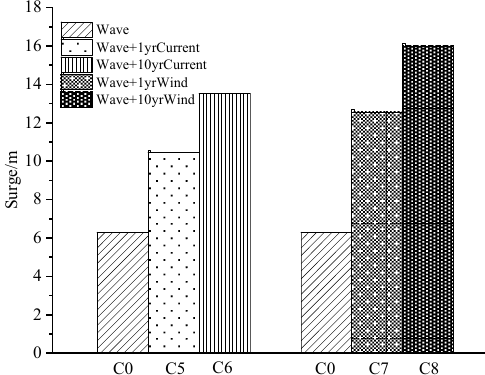
Figure 21. RMS for surge responses.